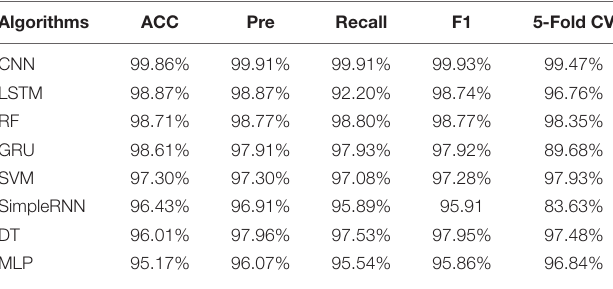
TABLE 1 | Comparative analysis of the predicative capabilities of eight machine learning algorithms on surfaced enhanced Raman spectra (SERS) spectral data belonging to 15 bacterial